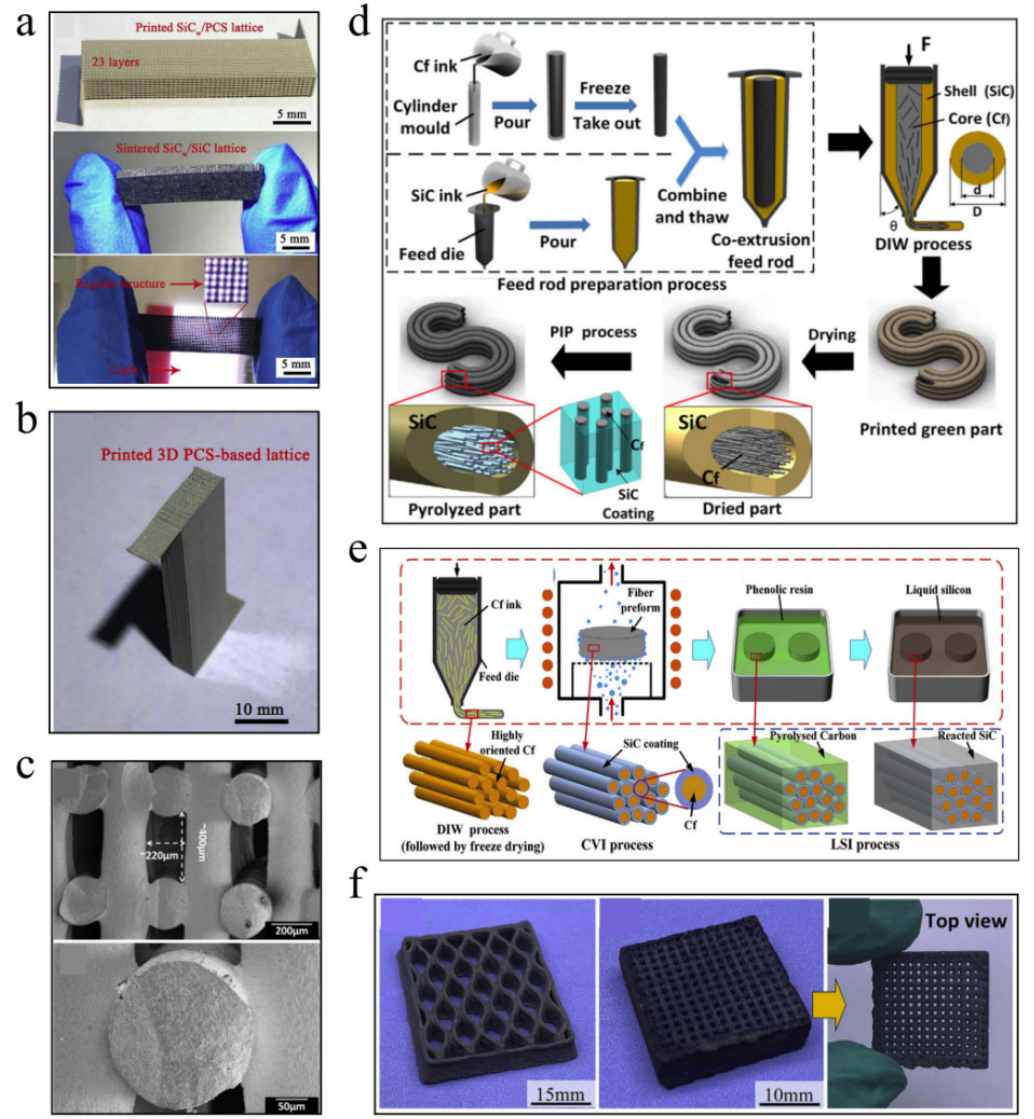
Fig. 34 DIW of second phase reinforced SiC ceramic: (a) SiC w /SiC ceramic. Reproduced with permission from Ref. [90], © Elsevier B.V. 2019. (b) SiC w /SiC ceramic. Reproduced with permission from Ref. [91], © Elsevier Ltd and Techna Group S.r.l. 2019. (c) SiCNW/SiC ceramic. Reproduced with permission from Ref. [92], © Elsevier Ltd and Techna Group S.r.l. 2019. (d) Fabrication flow chart of C f /SiC core–shell ceramic. Reproduced with permission from Ref. [93], © Acta Materialia Inc. 2019. (e) Fabrication flow chart of C f /SiC core–shell ceramic, (f) C f /SiC core–shell ceramic. Reproduced with permission from Ref. [94], © Elsevier Ltd and Techna Group S.r.l.